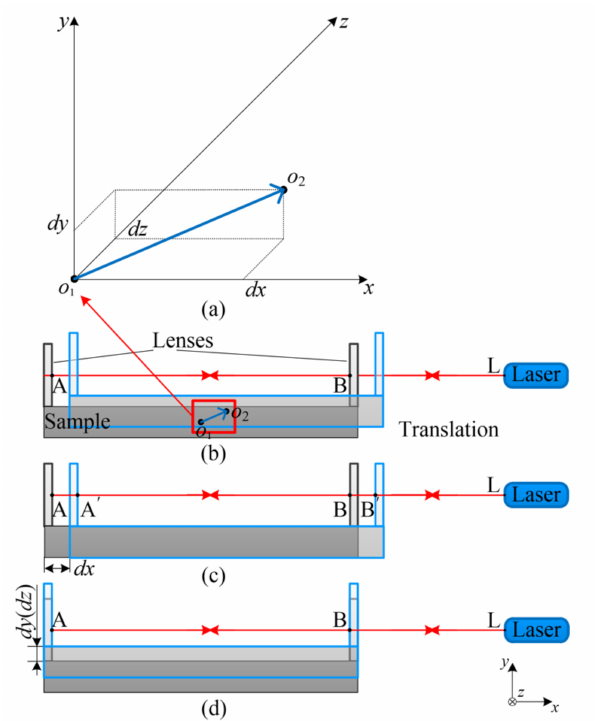
Figure 5. Schematic diagram of the translation displacement decomposition. ( a ) Translation displacement decomposition along the axis. ( b ) Total translation displacement. ( c ) The x component. ( d ) The y and z